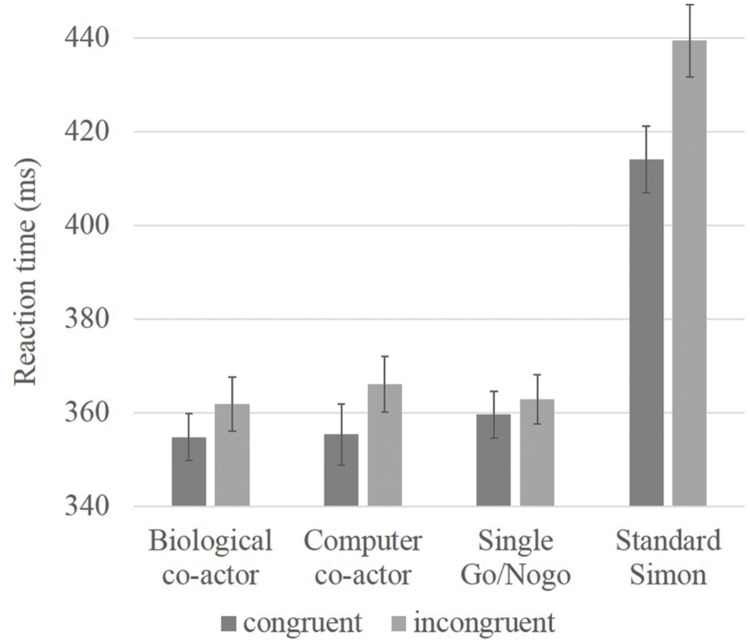
Bar graph showing reaction time data of congruency effects in believed biological co-actor, computer co-actor, single Go/Nogo, and standard Simon conditions. Reaction times were slower in the standard Simon task. Significant differences between incongruent and congruent conditions were observed in the believed biological co-actor and computer co-actor conditions, but not in the single Go/Nogo condition. Error bars depict the standard error.